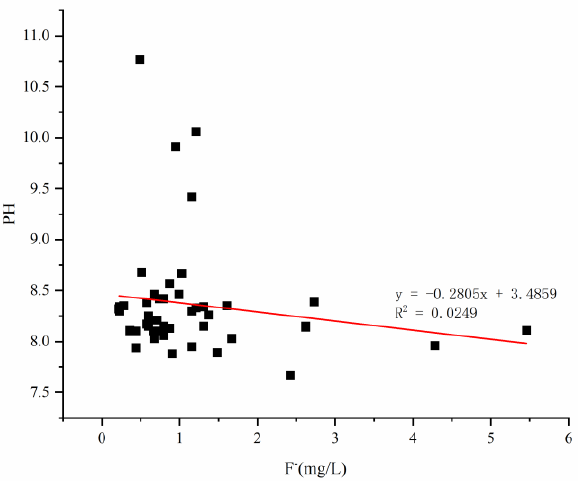
Figure 3. Relationship between the ρ[ F - ] and the pH value.